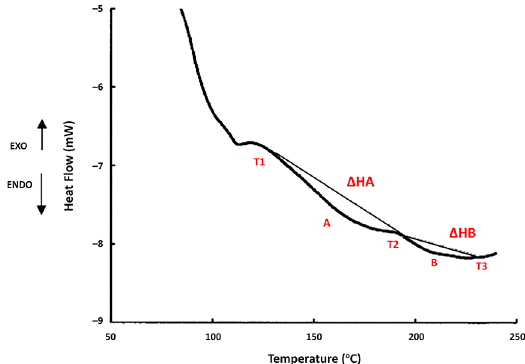
Figure 1. Obtention of ∆ Ha e ∆ Hb through the DSC